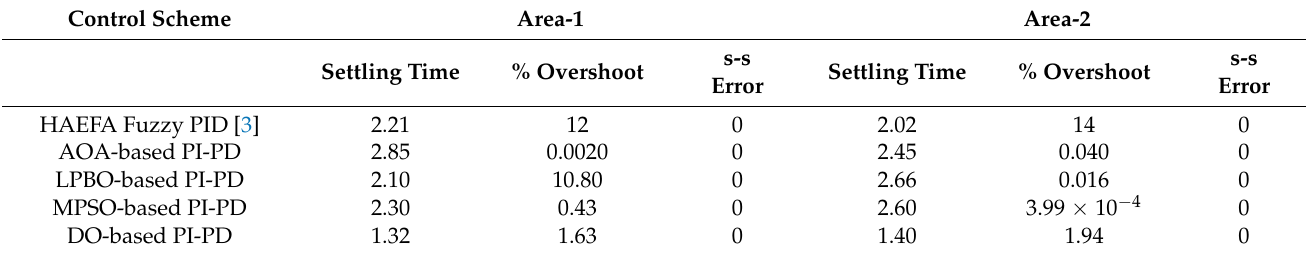
Table 6. Numerical results of an AVR in a two-area multi-source IPS.